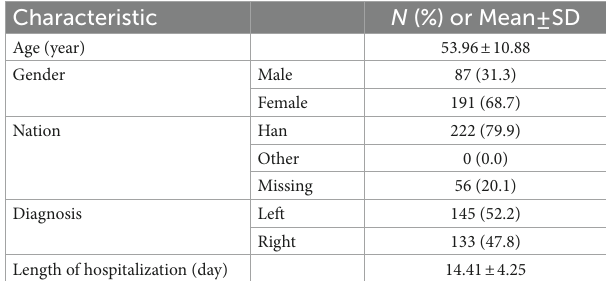
TABLE 1 Characteristics of 278 facial muscle spasm and trigeminal neuralgia